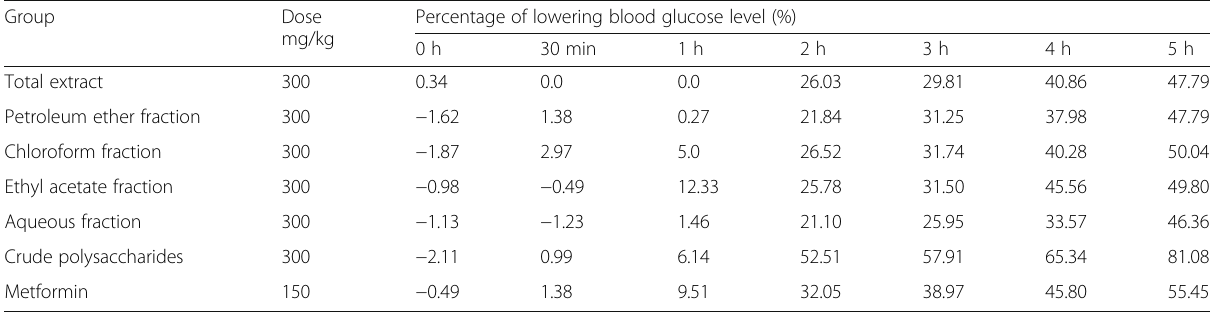
Table 7 Results of the effect of the total ethanolic extract and different fractions of A. hirtum leaves on the percentage of lowering blood glucose level on diabetic